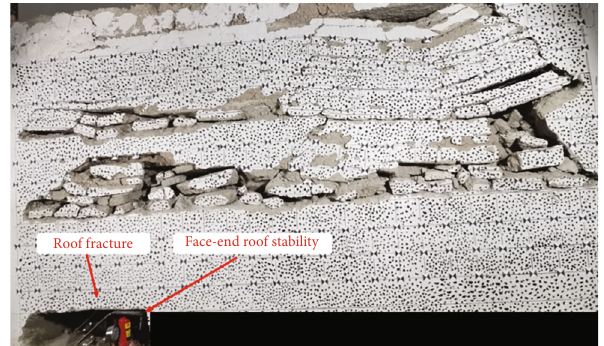
Figure 7: Roof state in normal mining.